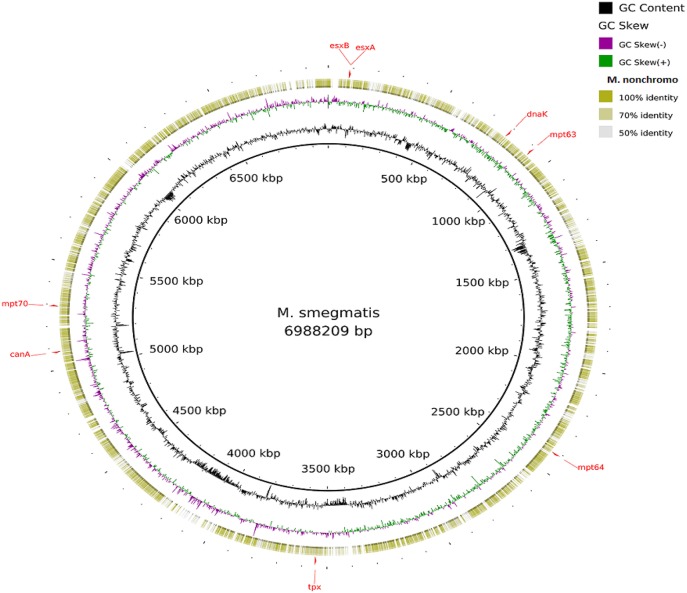
Alignment of M. nonchromogenicum predicted CDS regions to those of M. smegmatis MC2 155 (CP001663.1) using BRIG. Immunogenic proteins of interest identified in M. smegmatis are highlighted in red (esxB: locus tag MSMEG_0065, product hypothetical protein; esxA: locus tagMSMEG_0066, product early secretory antigenic target, 6 kDa; dnaK: locus tag MSMEG_0709, product of chaperone protein DnaK; mpt63: locus tag MSMEG_0828, product immunogenic protein MPT63; mpt64: locus tagMSMEG_2331, product immunogenic protein MPB64/MPT64; mpt70: locus tag MSMEG_5196, product fasciclin domain-containing protein; canA: locus tag MSMEG_4985, product carbonic anhydrase; tpx: locus tagMSMEG_3479, product thiol peroxidase).